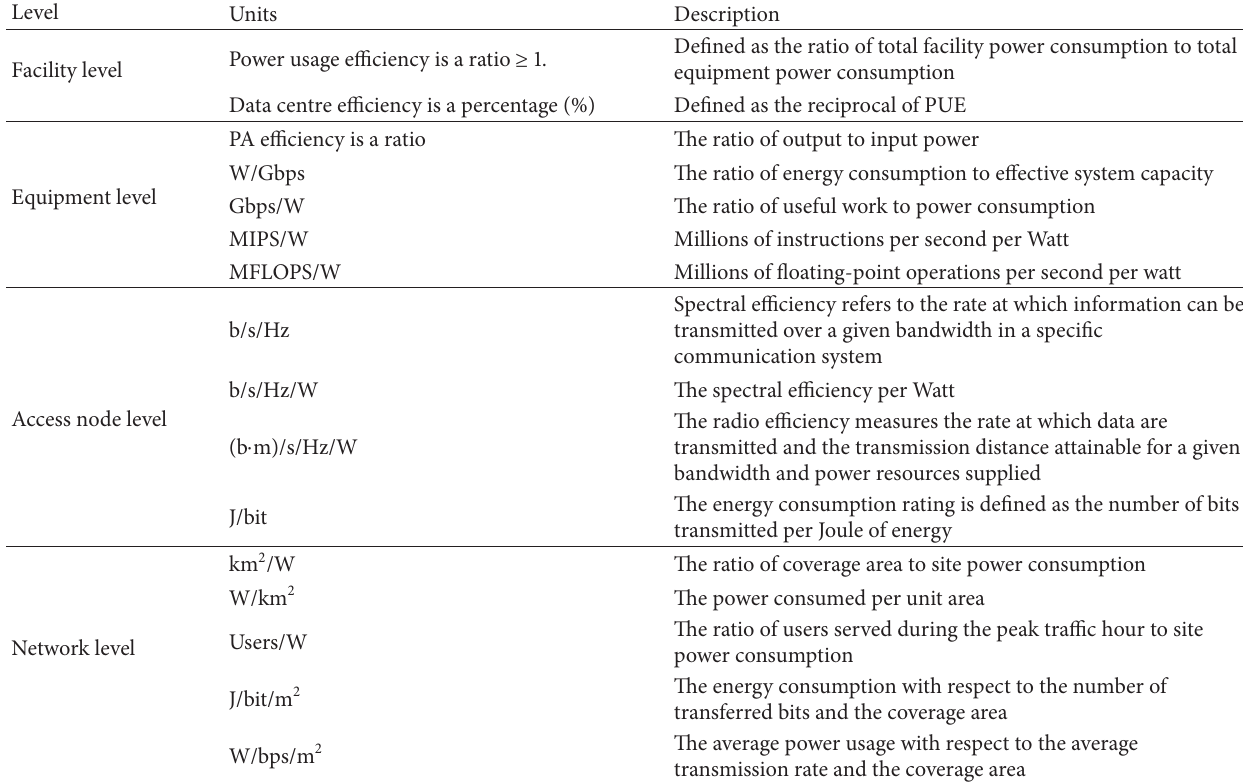
Table 1: Classification of some energy efficiency